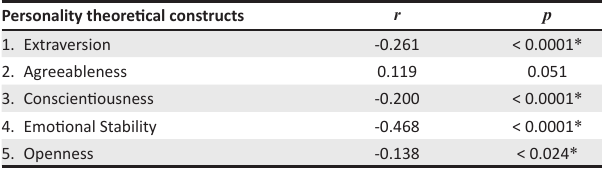
TABLE 3: Pearson product-moment correlations ( r ) and significance probabilities ( p ) for relations of strain-based conflict to personality theoretical constructs. Personality theoretical constructs